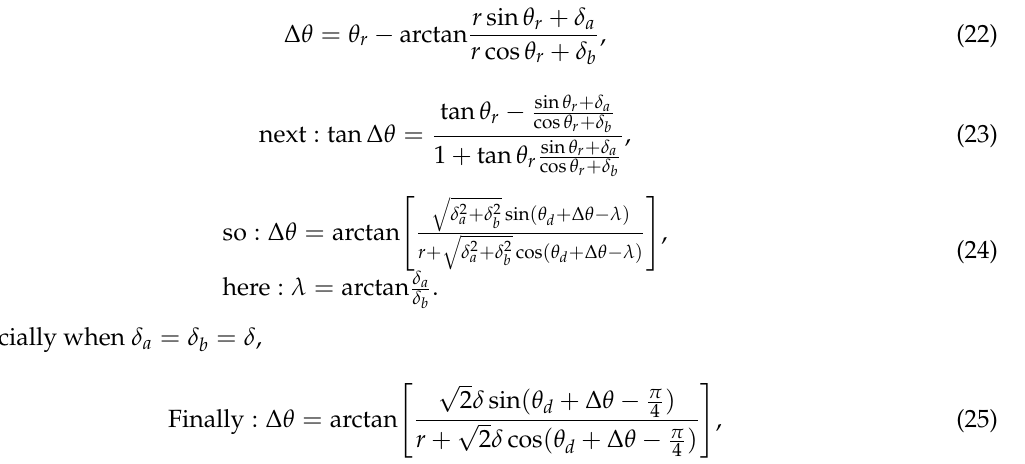
θ . Figure 4. Distribution law of ∆ θ N in one period of θ r r